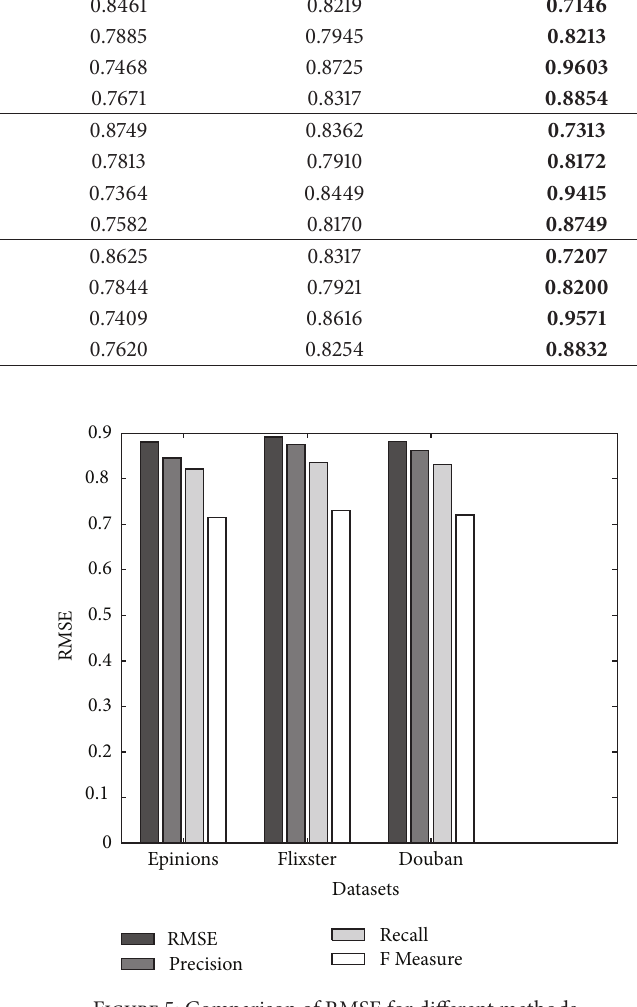
Figure 5: Comparison of RMSE for different